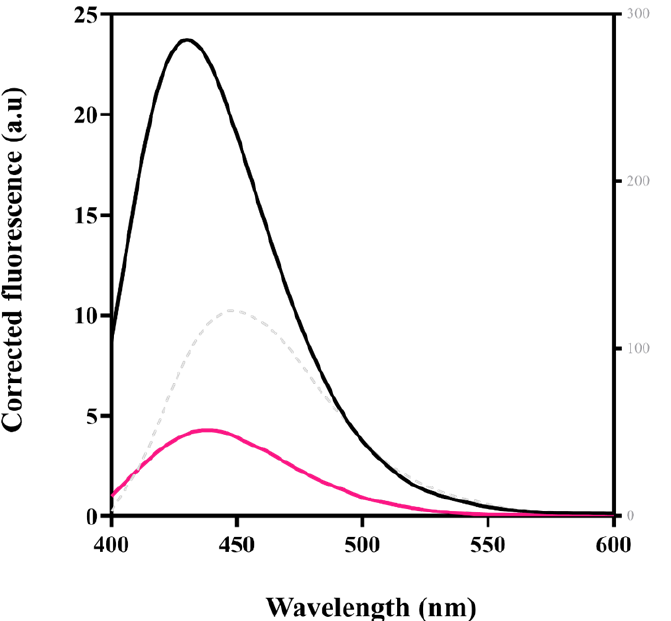
Figure 4. Fluorescence emission spectra of mant-ATP binding to KpNNAT. The binding of mant-ATP to the enzyme alone (black line), the enzyme in the presence of 1 mM ATP (pink line) and in the presence of 8 M urea (grey dotted line). Analyses were performed in 10 mM NaH 2 PO 4 , 0.01% NaN 3 , pH 7.5 containing 10 µM mant-ATP and 2.5 µM protein. Excitation was at 355 nm and emission spectra were collected between 400 and 600 nm. The plot was generated using GraphPad Prism.